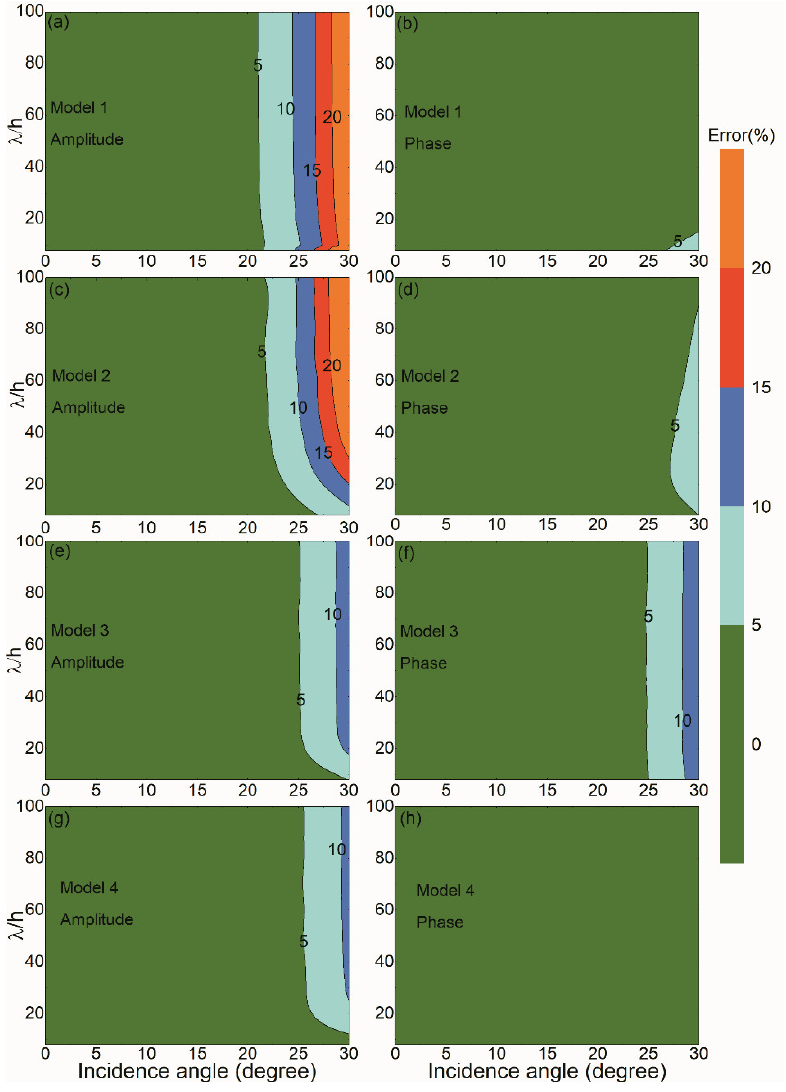
Figure 8. Relative errors of R PP induced by the second-order series approximation, ( a ) amplitude of Model 1, ( b ) phase of Model 1, ( c ) amplitude of Model 2, ( d ) phase of Model 2, ( e ) amplitude of Model 3, ( f ) phase of Model 3, ( g ) amplitude of Model 4, and ( h ) phase of Model 4.